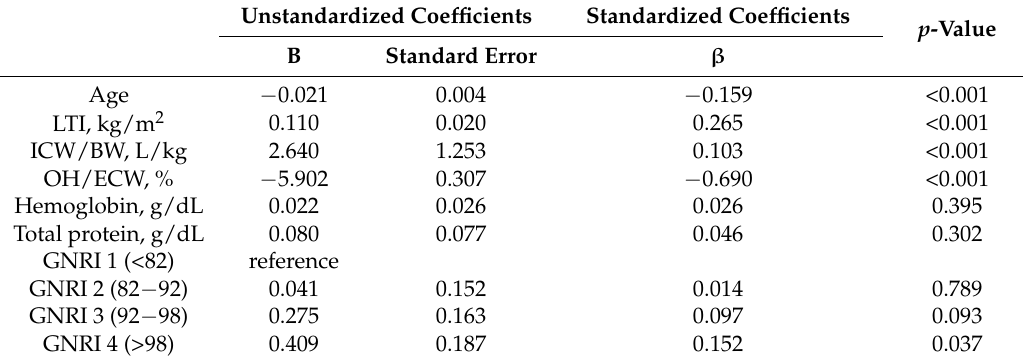
Table 3. Multiple linear regression analysis of variables influencing the phase angle ( N =